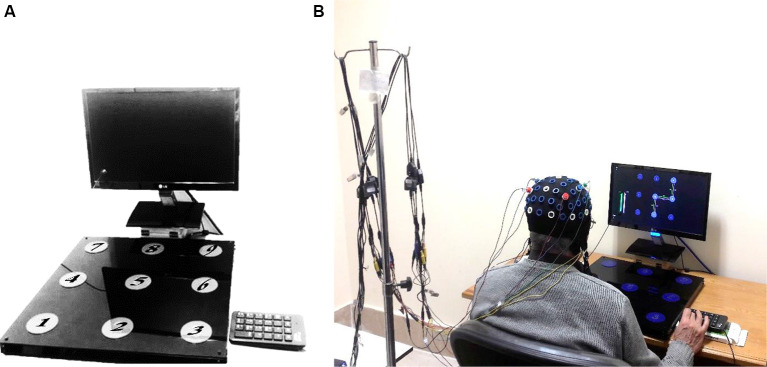
Sequential timing device (A), and procedure of experiment in progress (B).